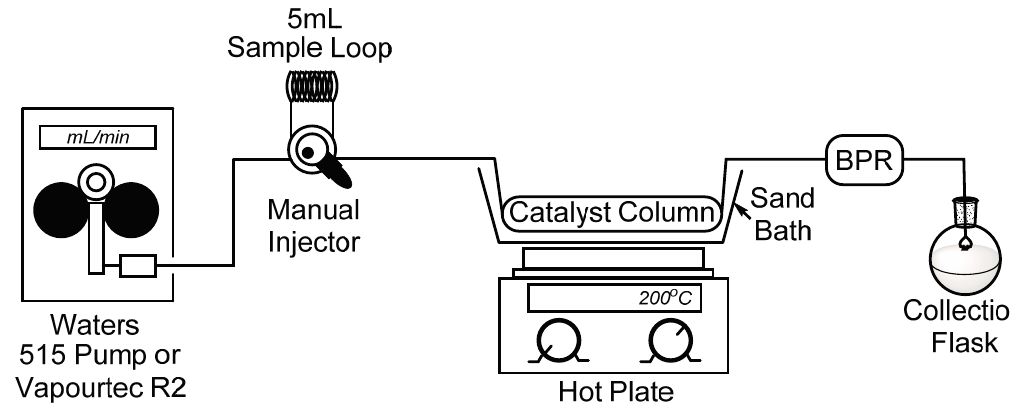
Figure 1. Simple flow chemistry setup for the synthesis of 2-methylpyridines; Waters 515 pump or Vapourtec R2 pumping module, manual dual mode (six-port) injector, steel column packed with Raney ® nickel, hot plate with sand bath, and back-pressure